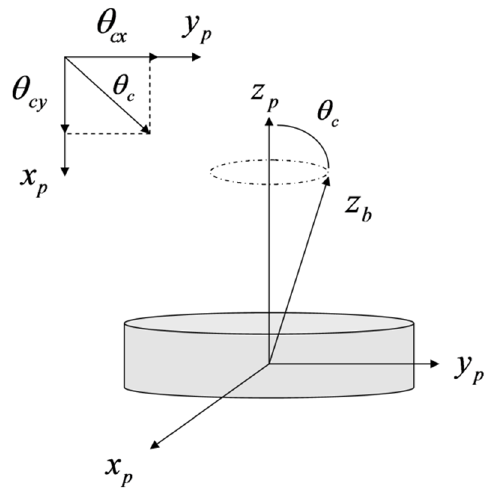
Figure 11. Spin-axis tilt (SAT).